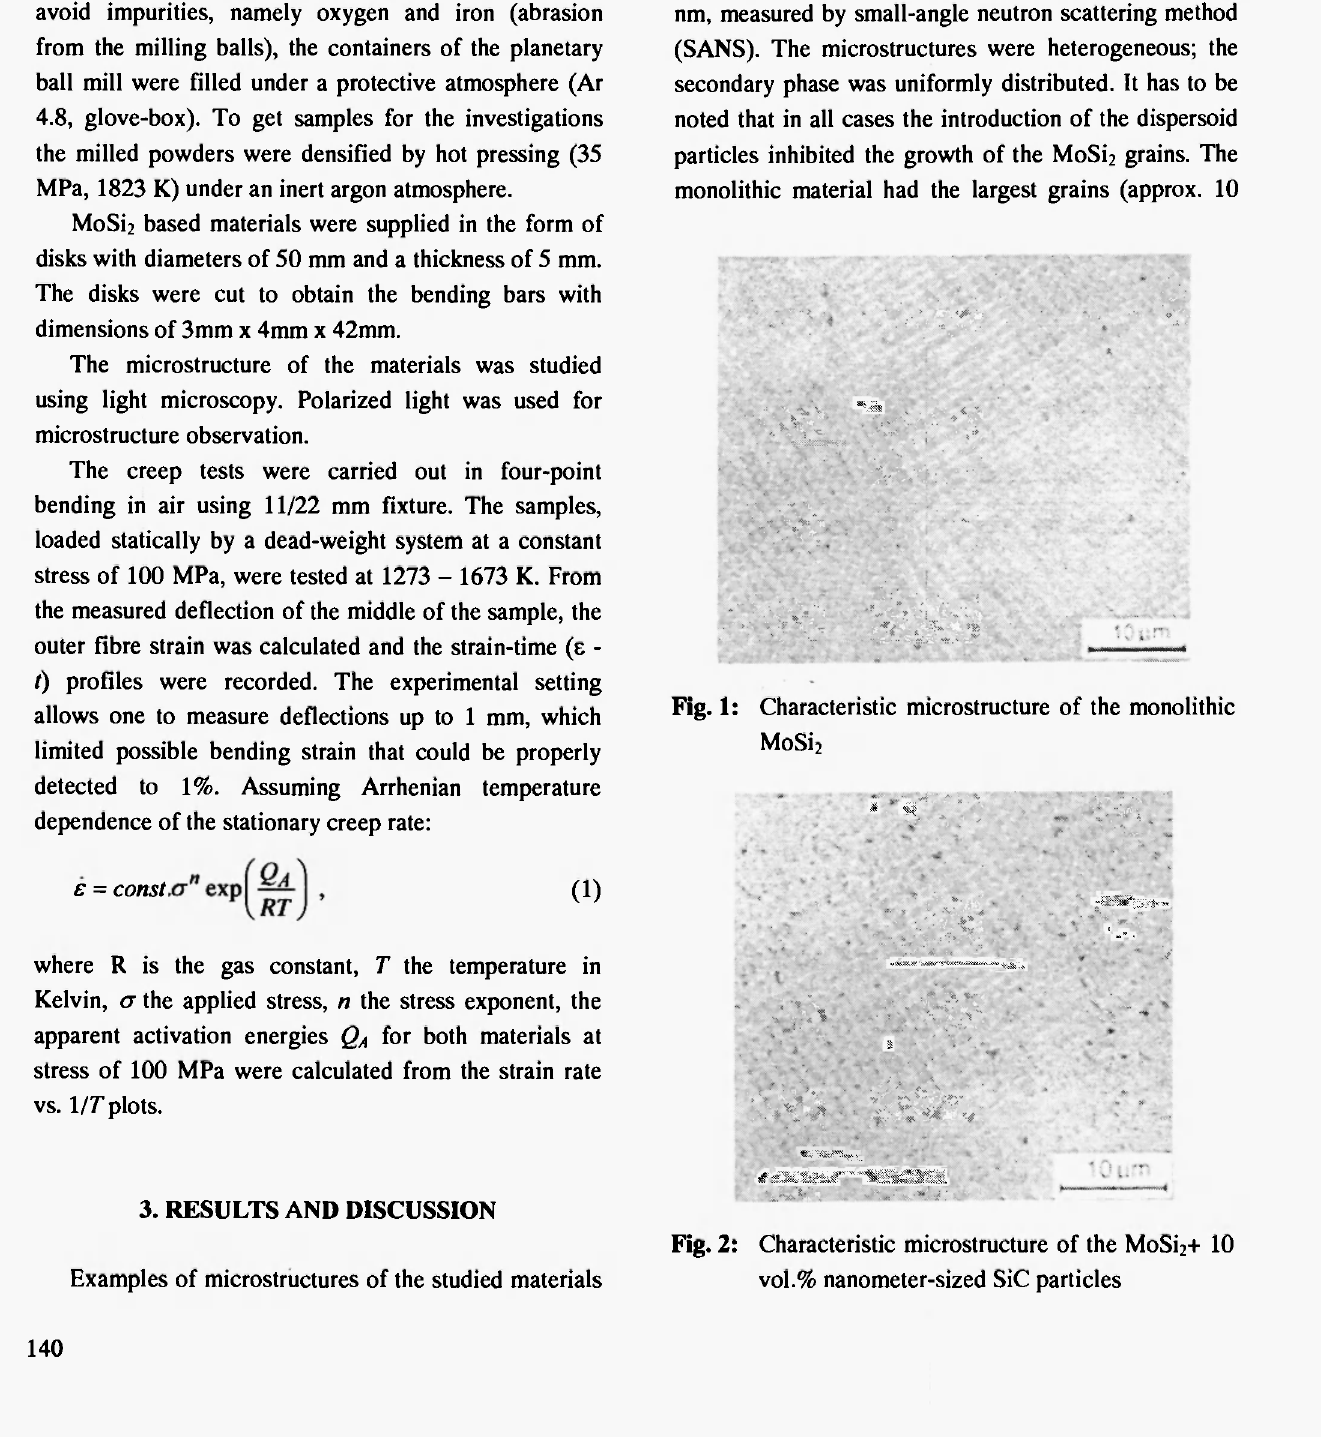
Fig. 2: Characteristic microstructure of the MoSi 2 + 10 vol.% nanometer-sized SiC